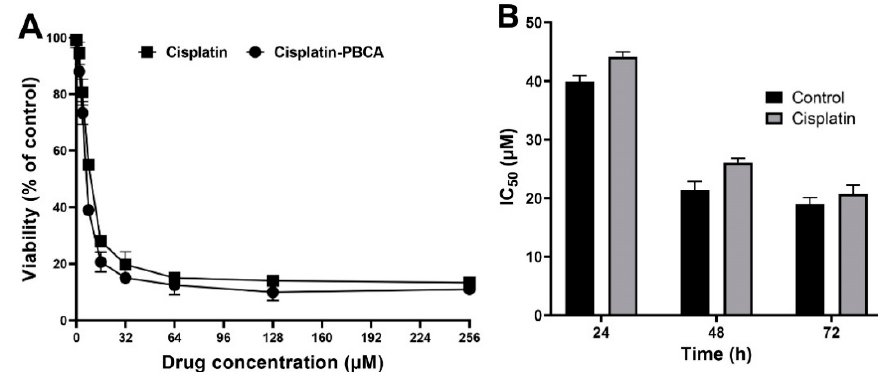
Figure 6. ( A ) Viability effects (% of control) of cisplatin-loaded PBCA nanoparticles compared to the standard drug (cisplatin) on human renal adenocarcinoma (ACHN) cells after 24-h incubation; and ( B ) cytotoxicity effects (IC 50 ) of the control (the combination of the free drug with blank PBCA nanoparticles) and cisplatin against ACHN cells (39.9 ± 1.0, 21.4 ± 1.5, and 19.0 ± 1.1 µM after 24-, 48- and 72-h incubation, respectively). The data were expressed as mean ± SD (n = 3).